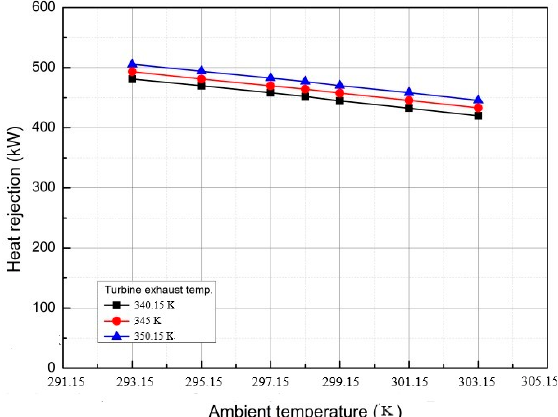
Energies 2019 , 12 , x FOR PEER REVIEW Figure 14. Influence of ambient temperature on heat rejection of cooling tower.